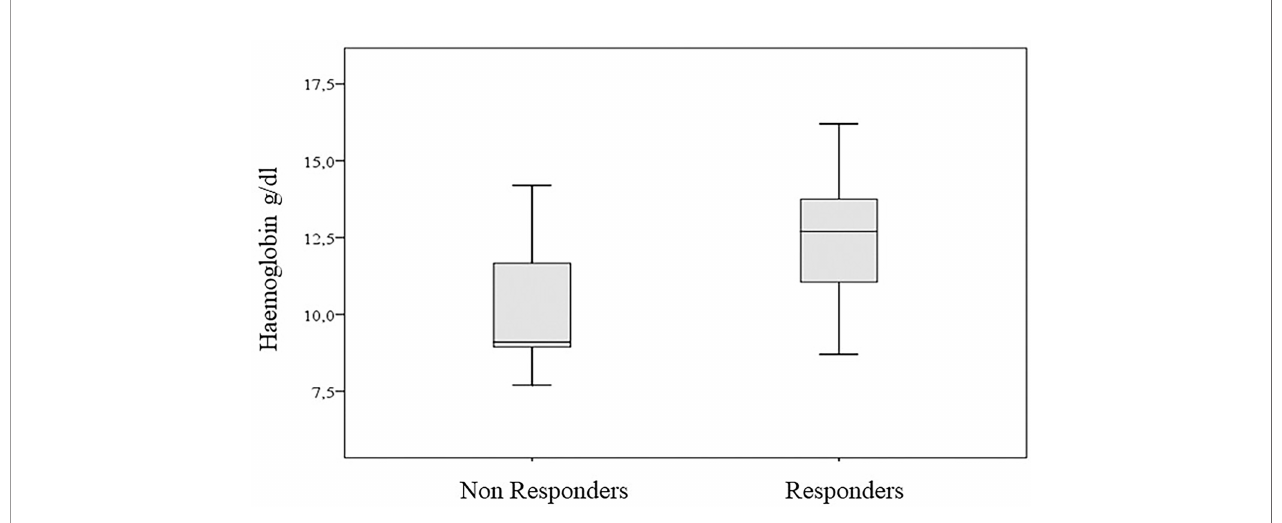
FIGURE 5 | Hemoglobin values according to clinical response.